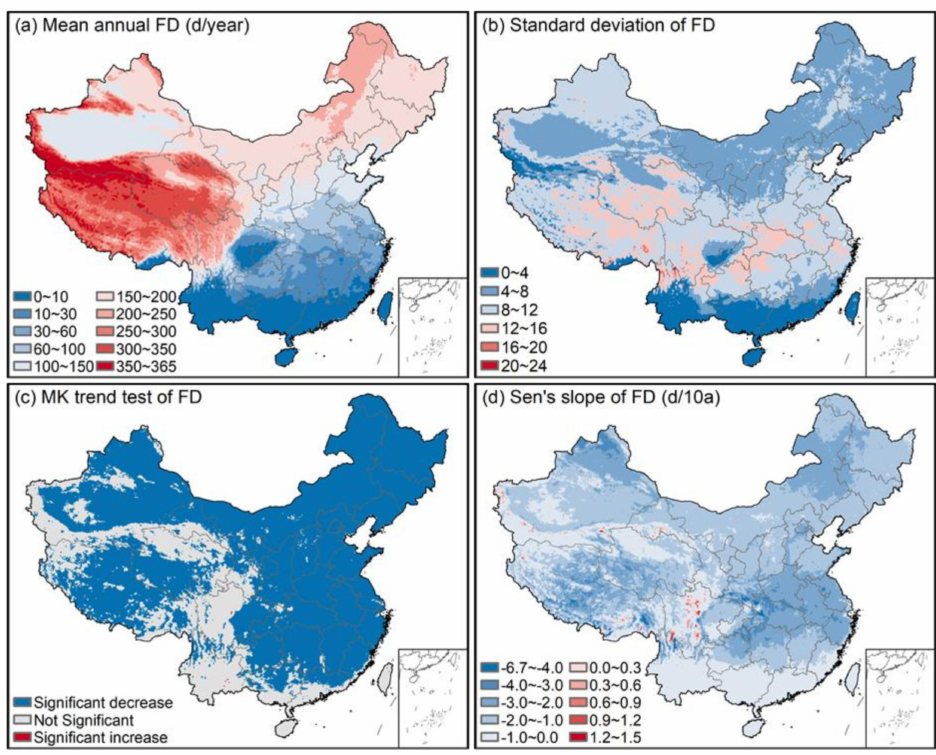
Figure 6. Spatial distribution of multi-year average annual FD, ( a ) standard deviation of FD, ( b ) trends of FD based on the Mann–Kendall trend test ( c ) and Sen’s slope of the FD ( d ) across China during the